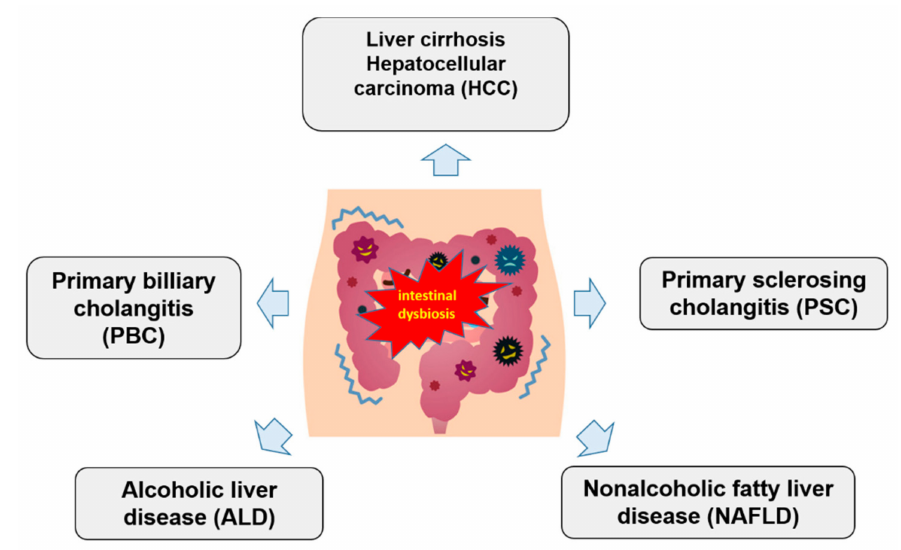
Figure 1. Schematic association between gut microbiota dysbiosis and chronic liver